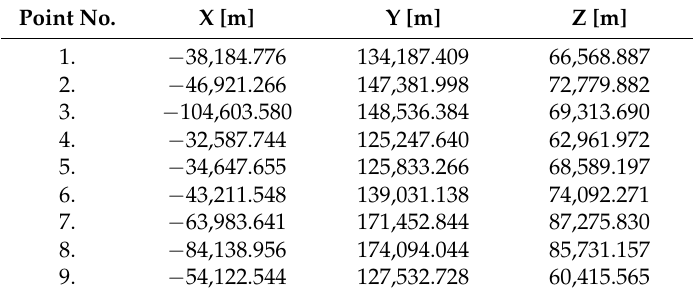
Table 3. Scaled, translated and rotated data set of points form Table